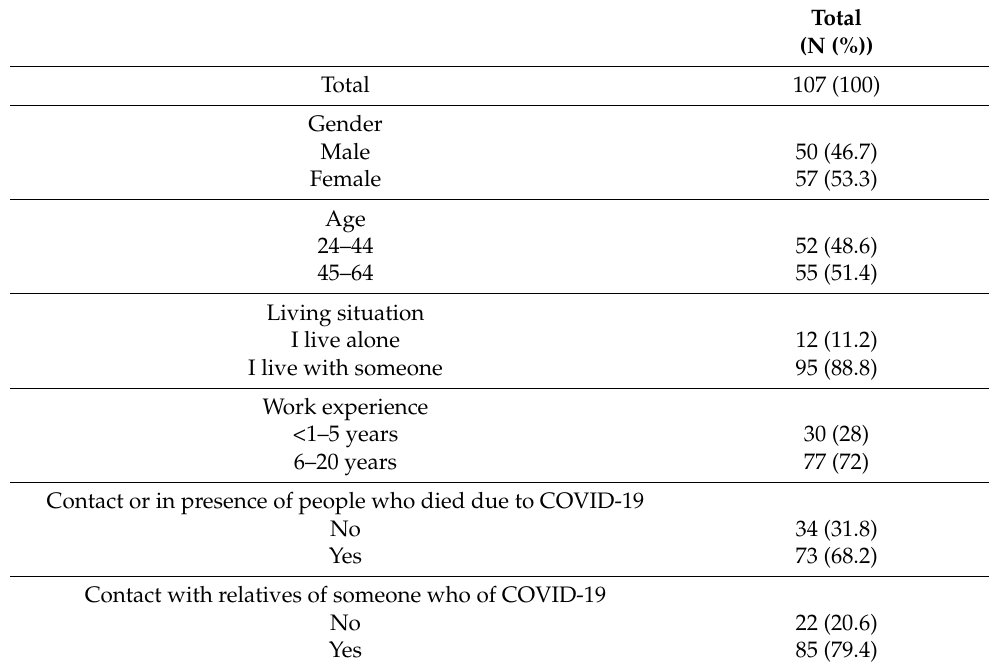
Table 1. Demographic Characteristics and PCL